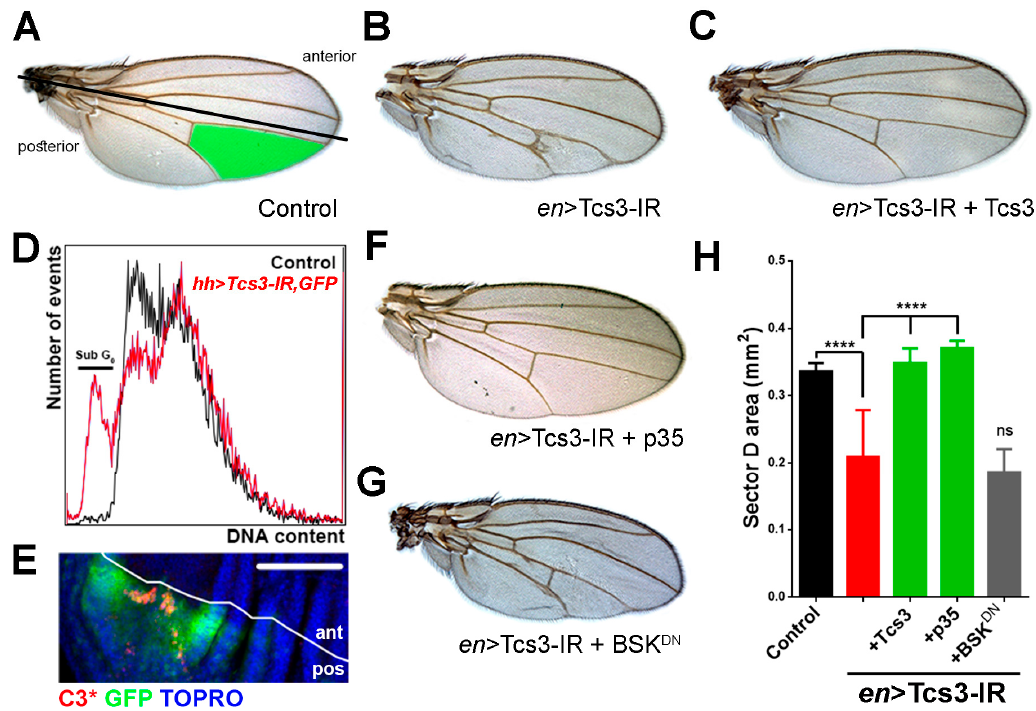
Figure 3. tcs3 knockdown causes apoptosis in imaginal cells. ( A ) Using the Gal4/UAS system tcs3 was knocked-down in the wing disc posterior compartment ( engrailed driver, en > Gal4; bottom part of the wing where the boundary between the anterior and posterior compartments is indicated with a black line). Representative pictures of the observed phenotypes are shown. Control ( en > Gal4/+); ( B ) tcs3 knock down ( en > Tcs3-IR); ( C ) co-expression of Tcs3 and Tsc3-IR; ( D ) hedgehog driver ( hh > Gal4) was used to knock down tcs3 and express GFP in the wing posterior compartment. Wing discs were disaggregated and cells analyzed by flow cytometry. Control cells (GFP-, anterior compartment) and GFP+ ( hh > Tcs3-IR, GFP) were analyzed for DNA content (DRAQ5). The sub G1 population is indicated by a black line over the curve; ( E ) cleaved Caspase-3 (C3*) was detected by immunofluorescence in wing discs in which tcs3 was silenced in the GFP expressing domain using the hedgehog driver. A white line indicates the boundary of the anterior (ant) and posterior (pos) compartments; bar 100 µ m; ( F ) Simultaneous tcs3 knockdown and p35 expression or ( G ) BSK dominant negative (BSK DN ) expression. ( H ) Quantification of the area of sector D in the wings of these animals (green section in control) ( n = 15, ANOVA, p <